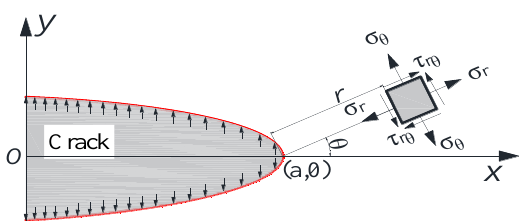
Figure 19. Stress field of frost heaving force at crack tip.